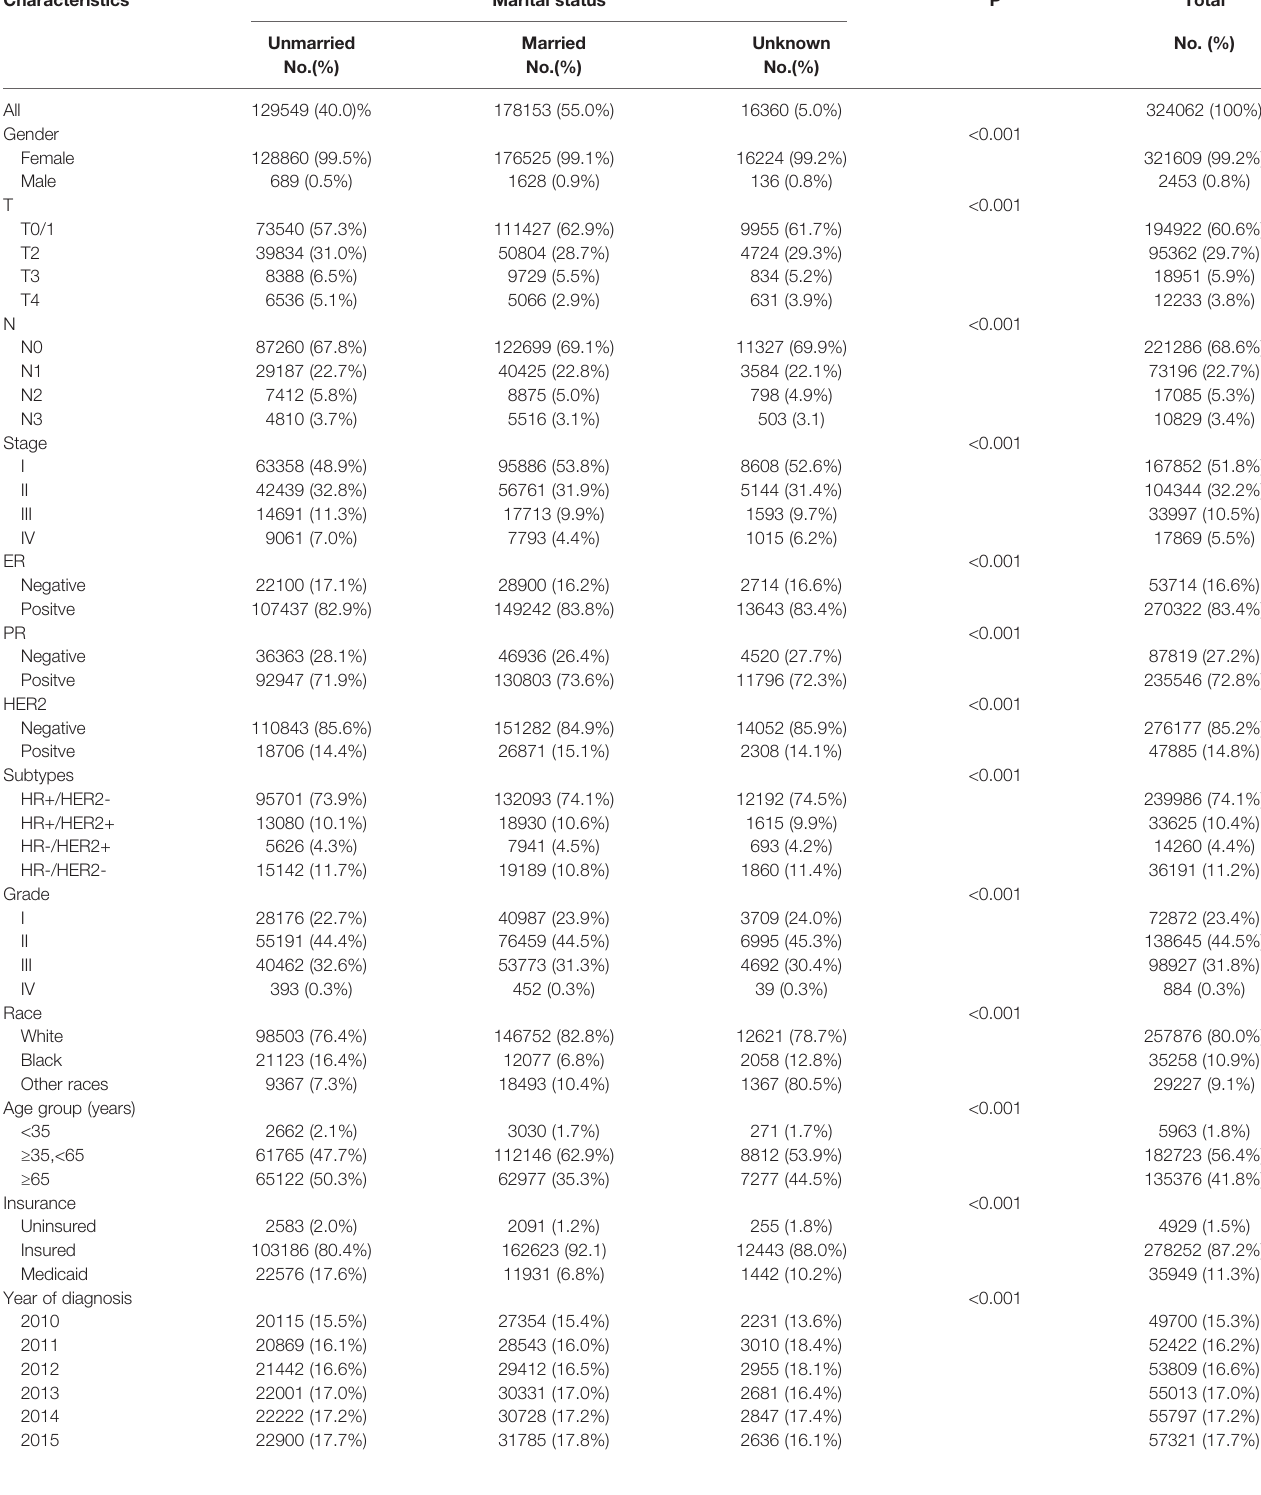
TABLE 1 | Clinicalpathologic characteristics of subjects according to marital status.